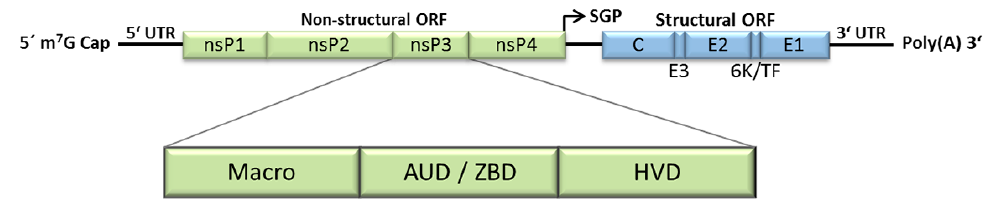
Figure 1. Alphavirus genome and nsP3 domains. The alphavirus genome is a positive-sense single-stranded RNA molecule, which contains two ORFs. The 5 ′ ORF encodes the non-structural proteins (nsP) 1–4 and the 3 ′ ORF encodes the structural proteins (Capsid (C), envelope glycoproteins (E1–3), a 6 kDa protein (6K) and the transframe protein (TF), which is comprised of a C-terminal extension of the 6 K protein after a frameshift event). nsP3 is subdivided into three domains, the macro domain, the alphavirus-unique or zinc-binding domain (AUD/ZBD) and the hypervariable domain (HVD). m 7 G—7-methylguanosine; UTR—untranslated region; ORF—open reading frame; SGP—subgenomic promoter; Poly(A)—polyadenylation.